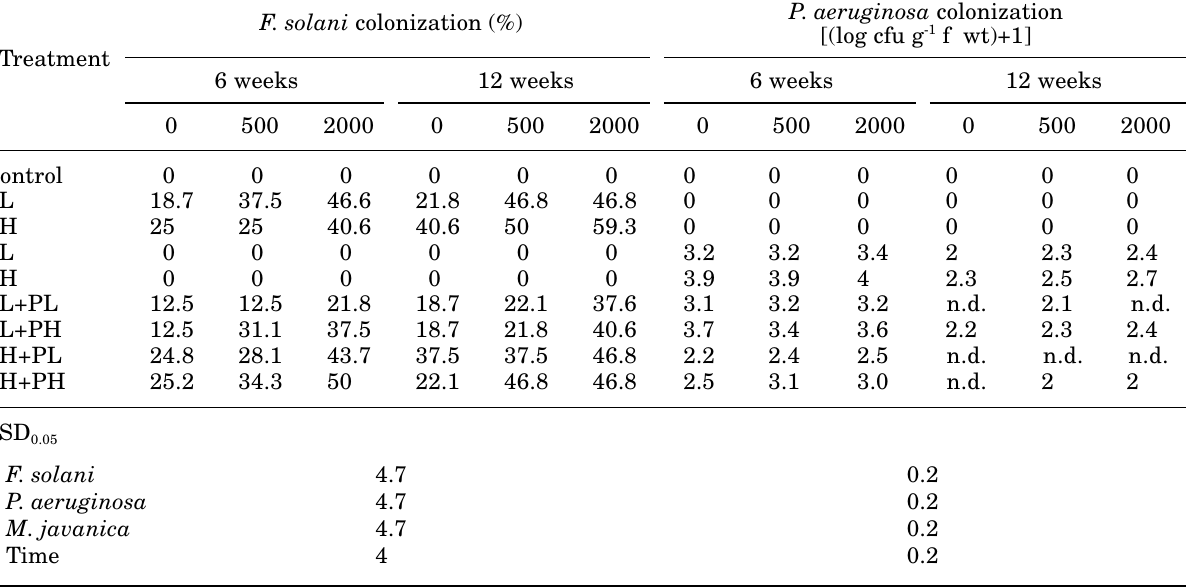
Table 3. Inner root colonization by Pseudomonas aeruginosa and Fusarium solani and fungal infection in Meloido- gyne javanica females and eggs extracted from tomato roots harvested 6 and 12 weeks after inoculation with 0, 500 or 2000 M. javanica juveniles per pot and treated with F. solani at rates of 10 6 (FL) or 10 7 (FH) cfu ml -1 suspension, or with P. aeruginosa at rates of 10 7 (PL) or 10 8 (PH) cfu ml -1 suspension, or with combinations of the two (FL+PL;